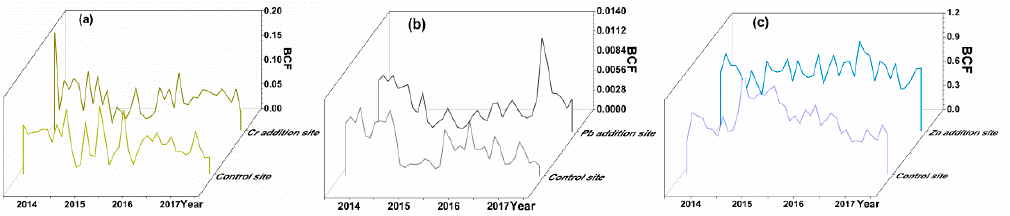
Figure 3. Bioconcentration factor (BCF) of heavy metal in wheat from 2014 to 2017: ( a ) Cr; ( b ) Pb; and ( c )